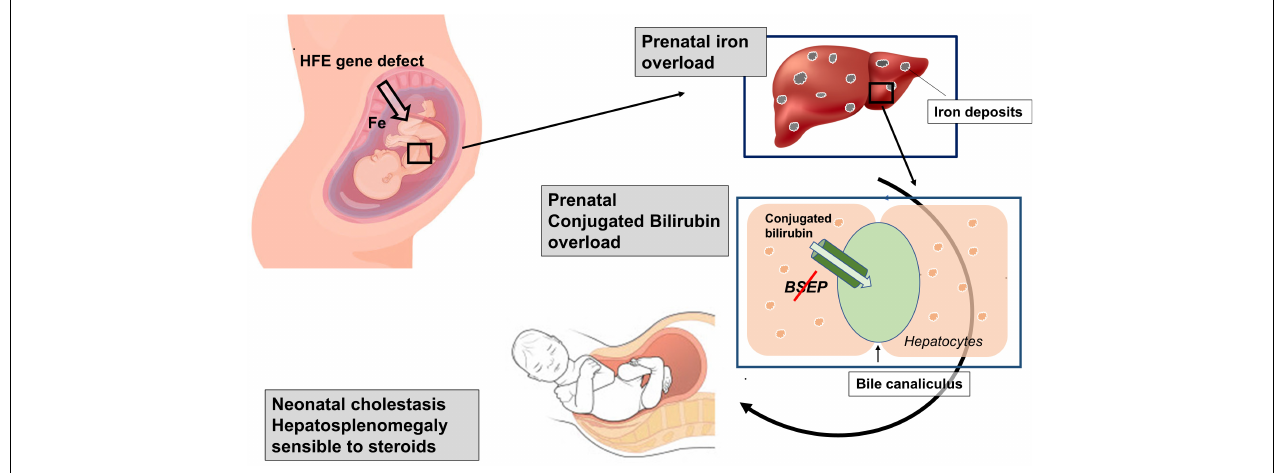
FIGURE 2 | Schematic representation of the suggested double overloads: The genetic defect predisposes the fetus to an intrauterine iron overload, able to inhibit the function of the bile salt export pump (Bsep). The consequent bilirubin overload, which probably already occurred in the uterus, is probably responsible for the hepatosplenomegaly